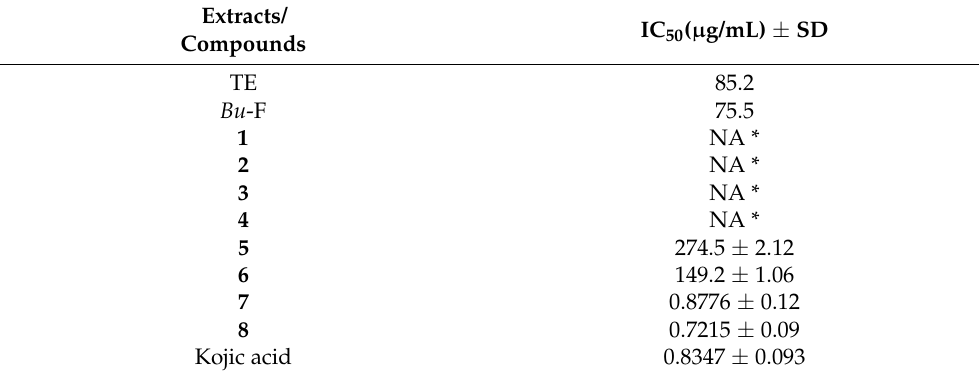
Table 3. Tyrosinase inhibitory activity of the isolated